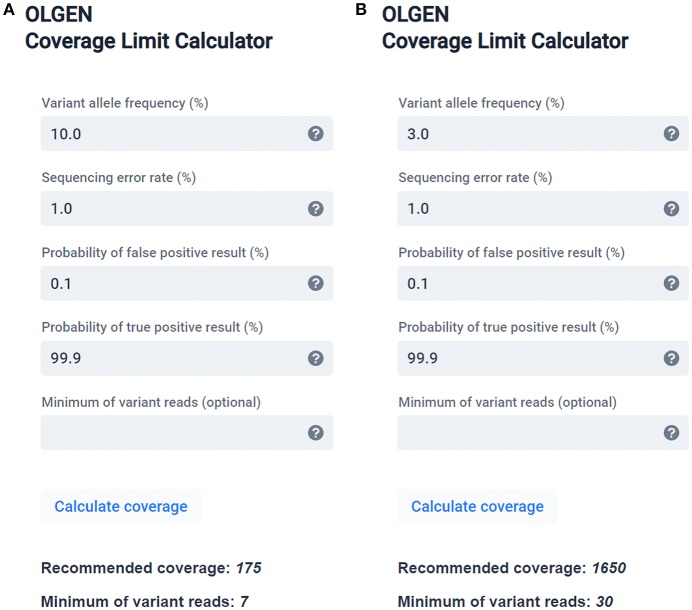
OLGEN Coverage Limit calculator—a simple theoretical calculator suitable for determining the correct sequencing depth and corresponding minimum number of variant reads according to the binomial distribution for a given sequencing error rate and intended LOD recommended for diagnostic NGS. Examples of calculated sequencing depths and the corresponding minimum number of variant reads recommended for variants with (A) 10% VAF and 99.9% probability of detection and (B) 3% VAF and 99.9% probability of detection.